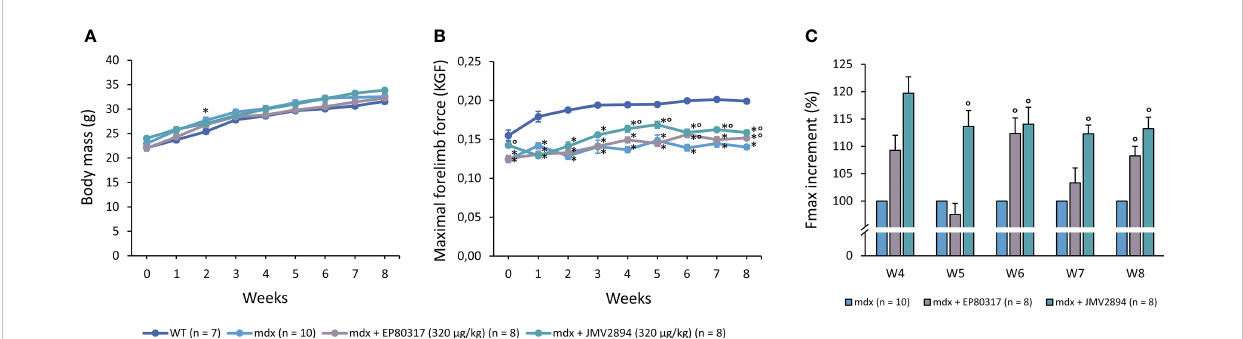
FIGURE 1 Values for body mass (BM, g; A ) and maximal forelimb grip strength (KGF; B ) at each weekly time point, and percentage of Fmax increment (%; C ) from W4 to W8, for all mice cohorts. Values are expressed as mean ± SEM from the number (n) of mice indicated in brackets. A statistically signi fi cant difference among groups was found by one-way ANOVA for BM at T2 (F > 3; p < 0.05) and for Fmax (F > 10; p < 0.0001) and Fmax increment (F > 4.9, p < 0.01) at all time points. Bonferroni post-hoc test for individual differences between groups is as follows: * vs. WT (0.02 < p < 0.05); ° vs. mdx (0.0004 < p <